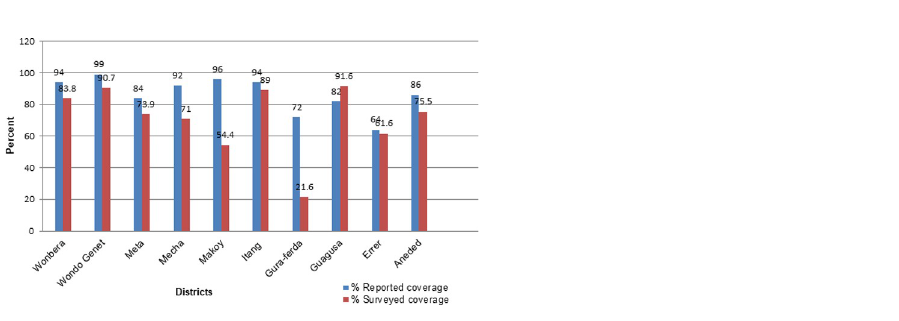
Fig 1. Comparison between reported and surveyed PC coverage against STH in ten districts of Ethiopia, 2019.